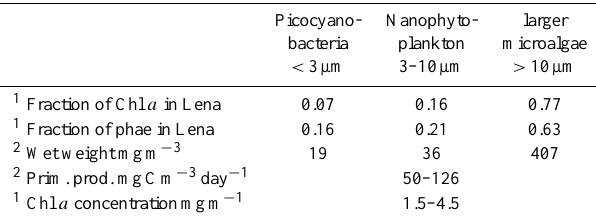
Table 1. Summary of the phytoplankton composition, size fraction, and total production in the Lena